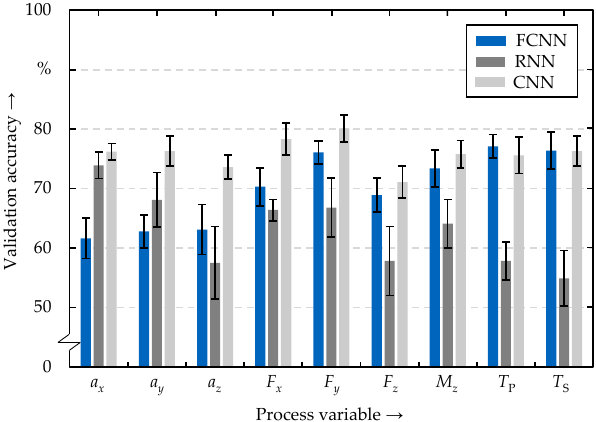
Figure 5. Achieved validation accuracies for the prediction of cavities.